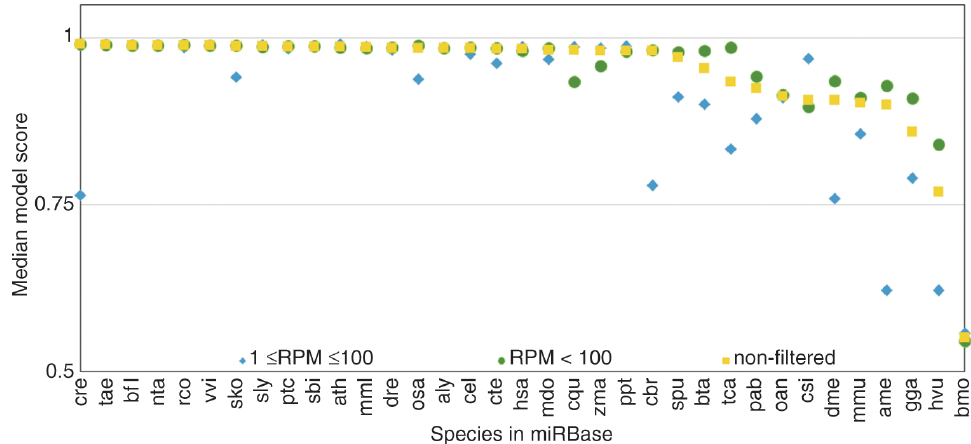
Figure 7: The performance of all species listed in miRBase which have at least 1 hairpin with ≥ 1 RPM. Median values for hairpins having RPM values less than or equal to 100 (RPM ≤ 100; blue), hairpins having RPM values larger than 100 (RPM > 100; blue) and all hairpins (nonfiltered; yellow) are